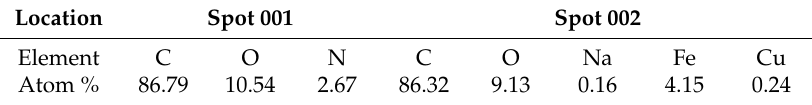
Table 1. Composition analysis results of the Fe 3 O 4 /carbon fiber (CF)